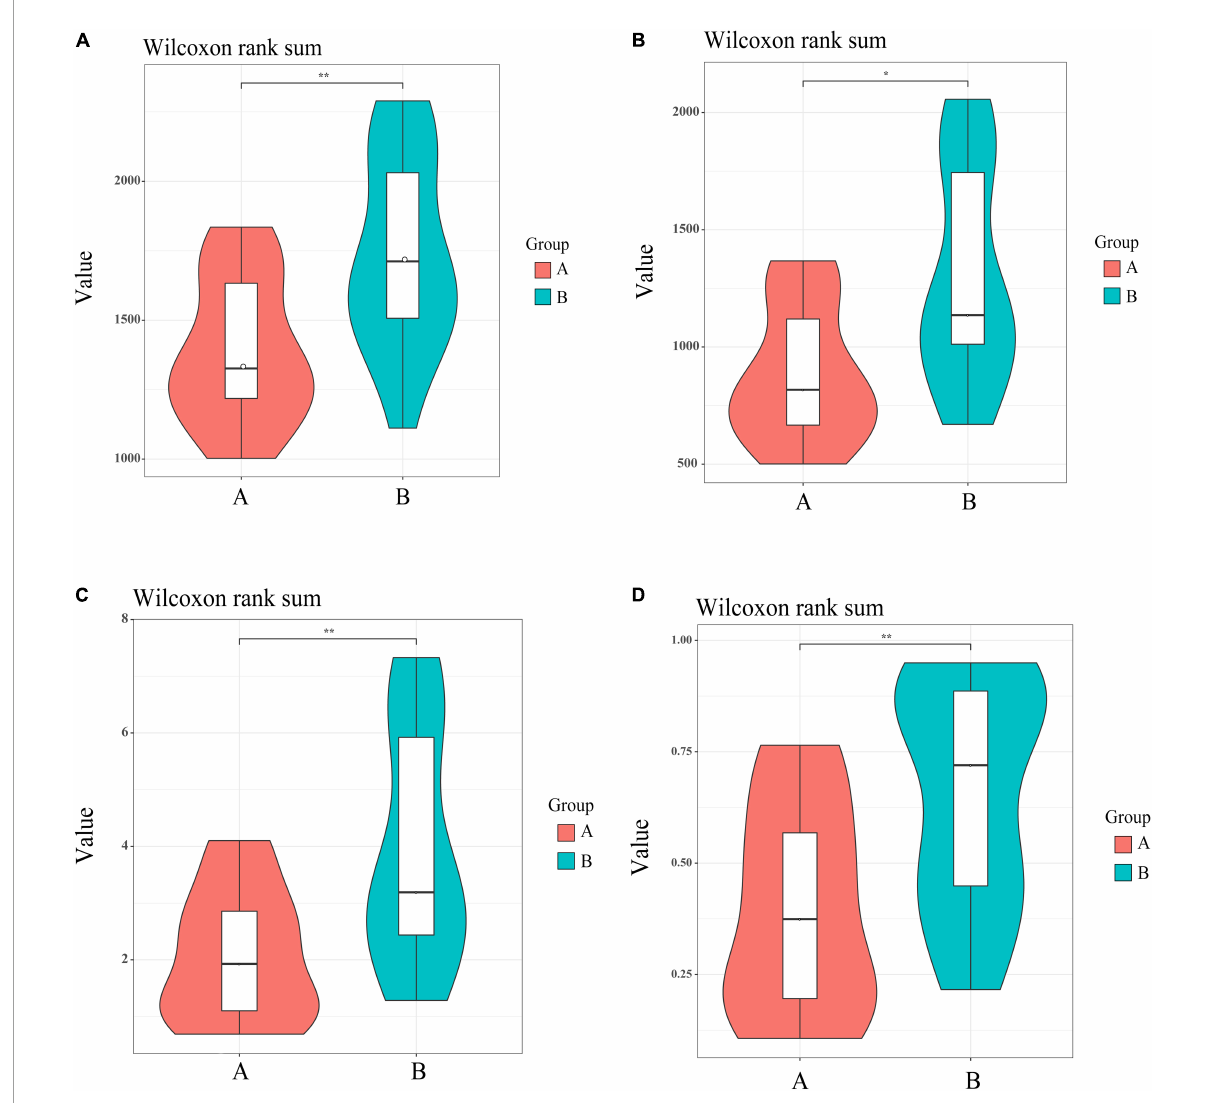
FIGURE3 Alpha diversity index of microbial communities in violin map. (A) Representative chao1 Index, (B) representative observed species, (C) representative Shannon Index, (D) representative Simpson index. *Correlation significant at 0.05 level. **Correlation significant at 0.01